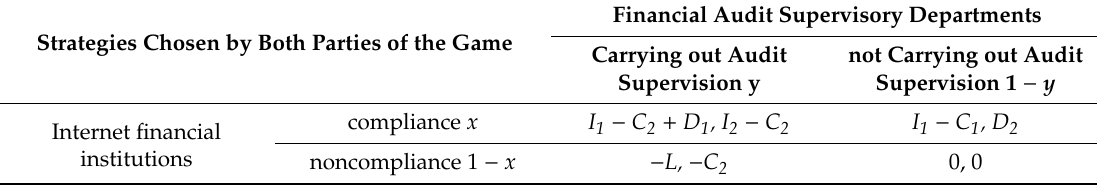
Table 1. Game utility matrix of Internet finance government audit